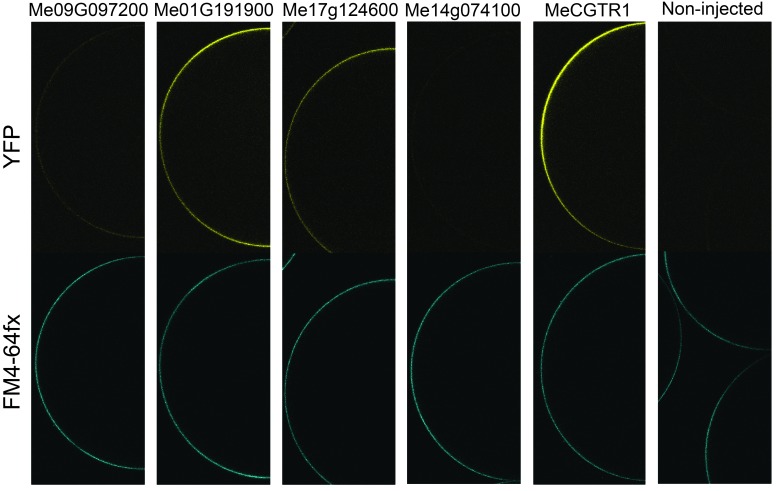
Expression analysis of YFP-tagged (C-terminal) GTR homologs from cassava in X. laevis oocytes.YFP fluorescence in yellow (top) and the plasmamembrane-staining dye FM4-64fx in blue (bottom). Shown are representative images of at least three oocytes.